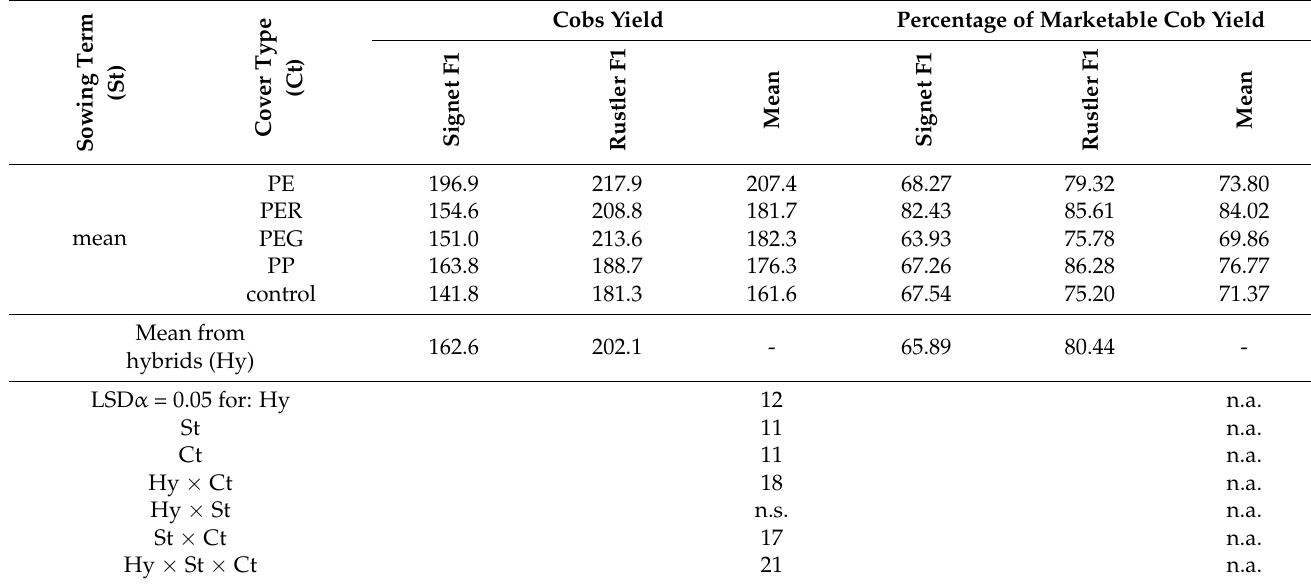
Table 3. Total cobs yield (dt per ha) and percentage (%) of marketable cobs yield. Average from years 2012–2014.